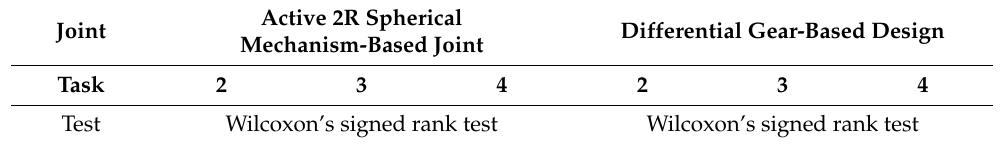
Table A6. Tests for control mode Table A7. Tests to compare the performance of the joints.